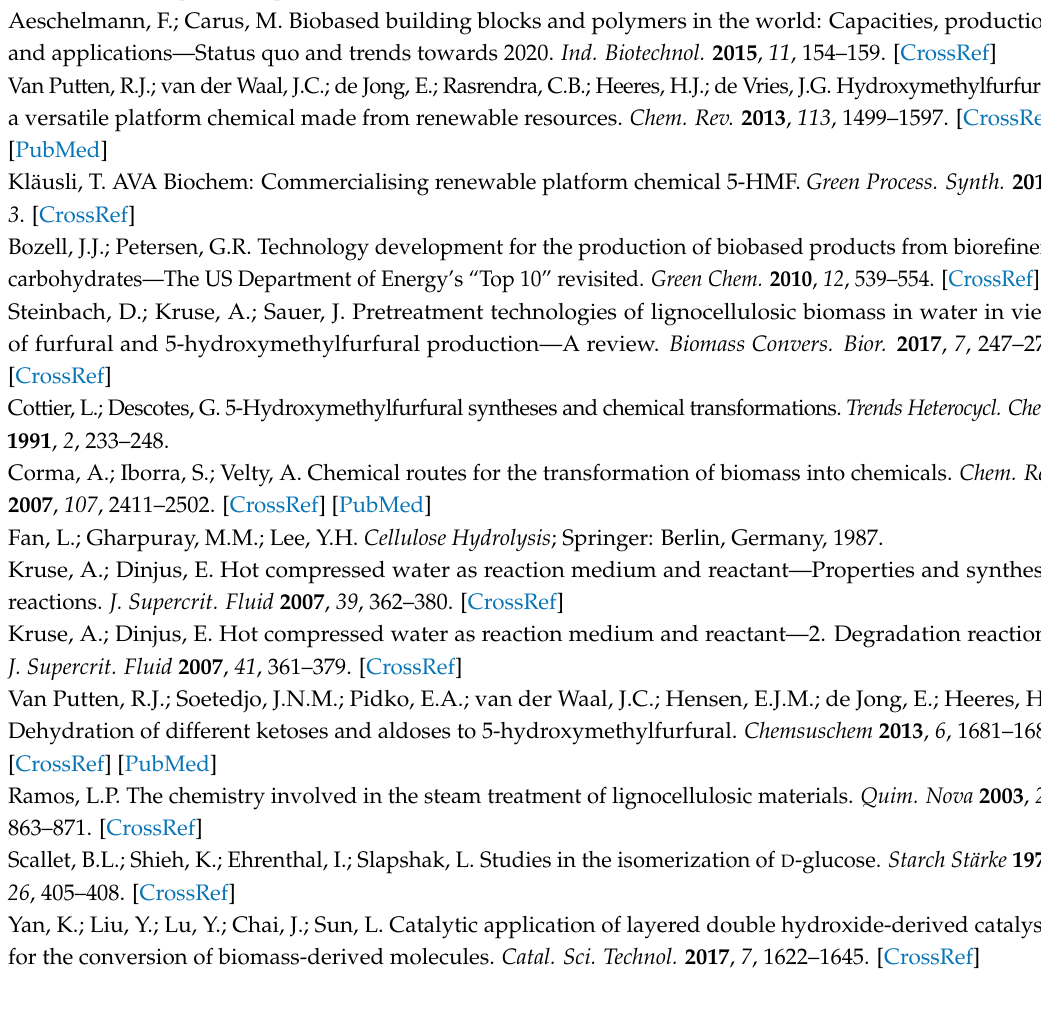
Table S1: Experimentally determined molar ratios y i,meas of the acid-catalyzed conversion of sucrose. Feedstock contained 2 wt % sucrose and 0.005 mol/L sulfuric acid. Table S2: Experimentally determined molar ratios y i,meas of the acid-catalyzed conversion of glucose or fructose, at 10 min residence times and 220 ◦ C. Feedstock contained 0.005 mol/L sulfuric acid and either 1.05 wt % glucose or 1.05 wt % fructose. Table S3: Activation energy EA n and Arrhenius factor A n of the n first-order reactions as defined according to the